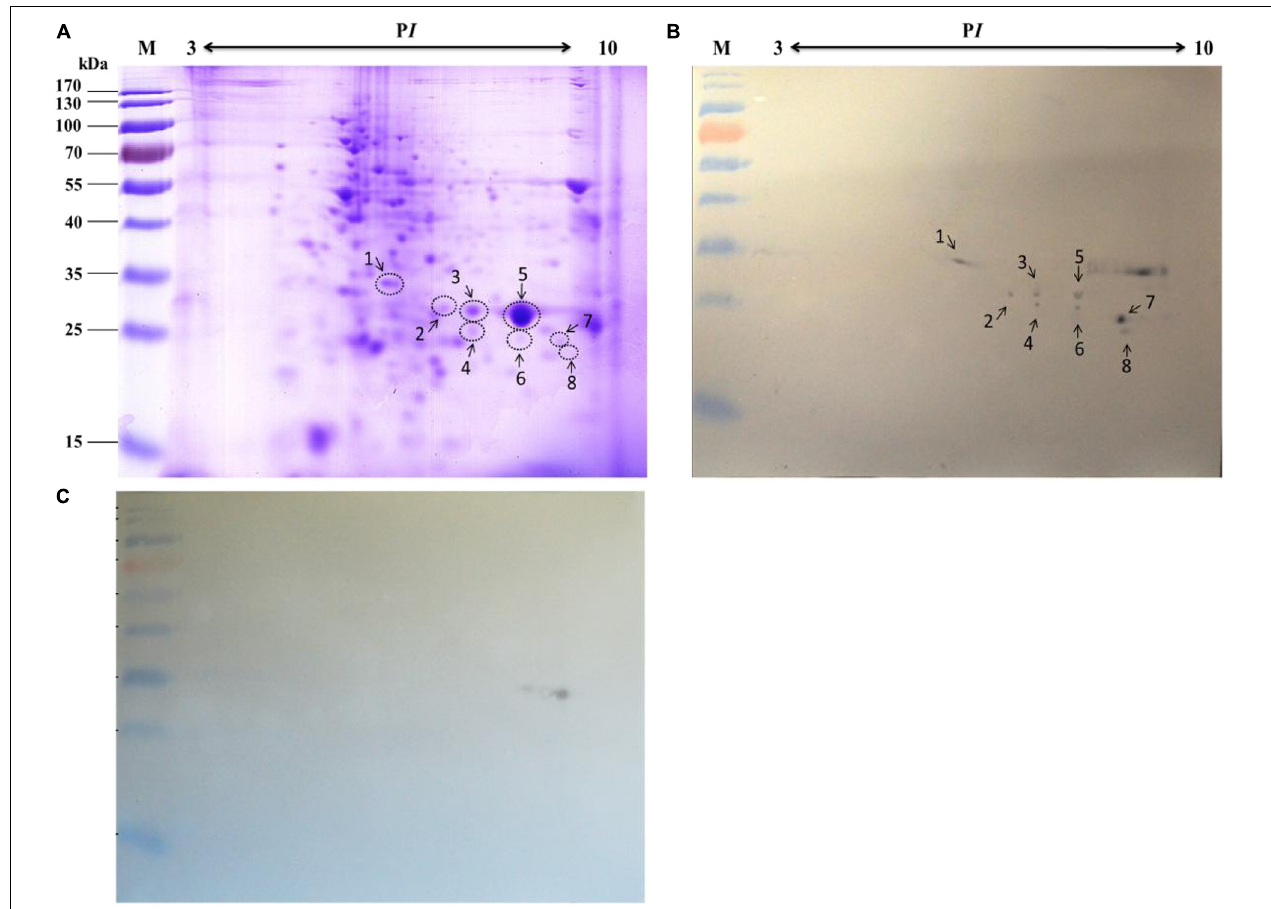
FIGURE 3 | Identification of virus-binding of the mitochondrial proteins fraction of the P50 midgut of the P50 midgut on 2-DE. (A) Bombyx mori midgut mitochondrial proteins submitted to 2-DE. Mitochondrial proteins blot were overlaid (B) or not ( C ; negative control) with BV, and antibodies against the AcMNPV gp64 protein were used to detect the BVs. Arrows 1–8 in (A,B) refer to the spots detected on corresponding proteins in the stained gel and the PVDF membrane. M, protein molecular weight marker. TABLE 2 | Identification of BV binding proteins in B. mori midgut mitochondria separated by 2-DE and identified by MALDI-TOF/TOF MS. Spots No.